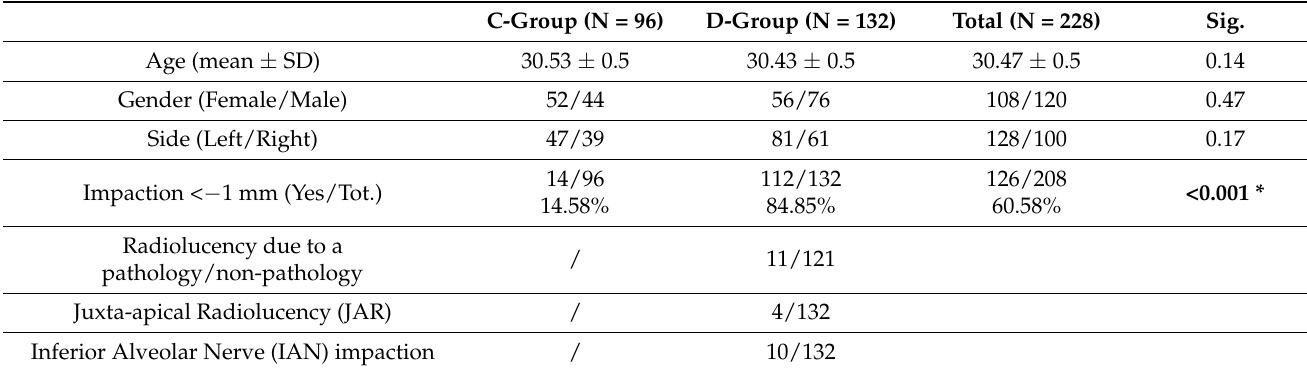
Table 1. demographic and clinical characteristics of D-group vs. C-group patients. N = number, SD = standard deviation, Sig = statistical significance using Chi-square and One-way ANOVA. *= p value with significance